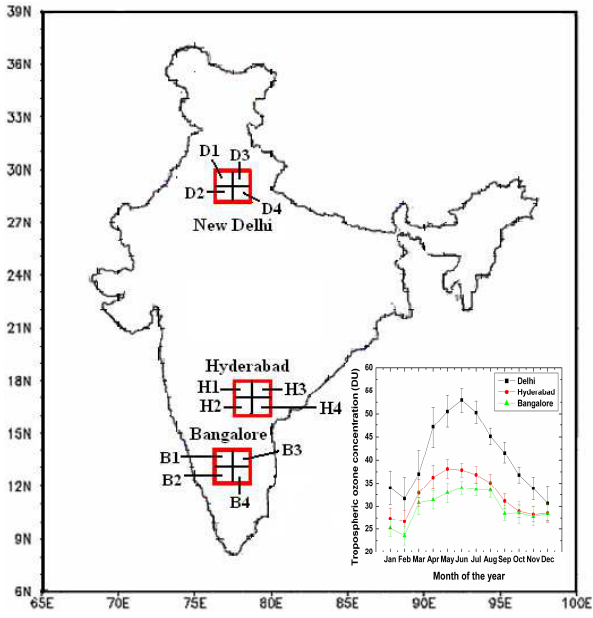
Figure 1504 Fig. 1. Map of India with three major inland cities Delhi, Hyder- abad and Bangalore with adjacent region used in this study (marked with red colour boxes). The inset shows the annual variation in av- eraged TOR over the three major inland cities Delhi, Hyderabad and Bangalore of India, for the period 1979–2005. The vertical bars show one sigma standard deviation.